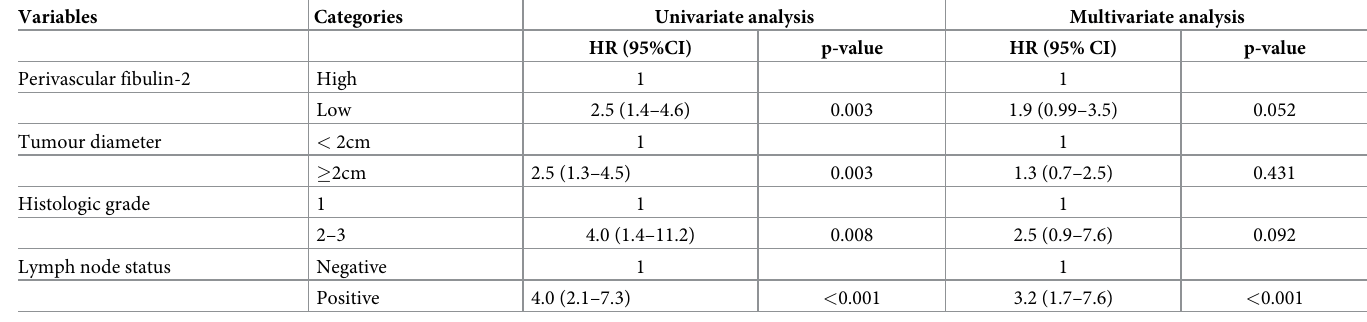
Table 4. Univariate and multivariate recurrence free survival analysis (Cox‘proportional hazard method) of pathological variables and perivascular fibulin-2 by immunohistochemistry (n =